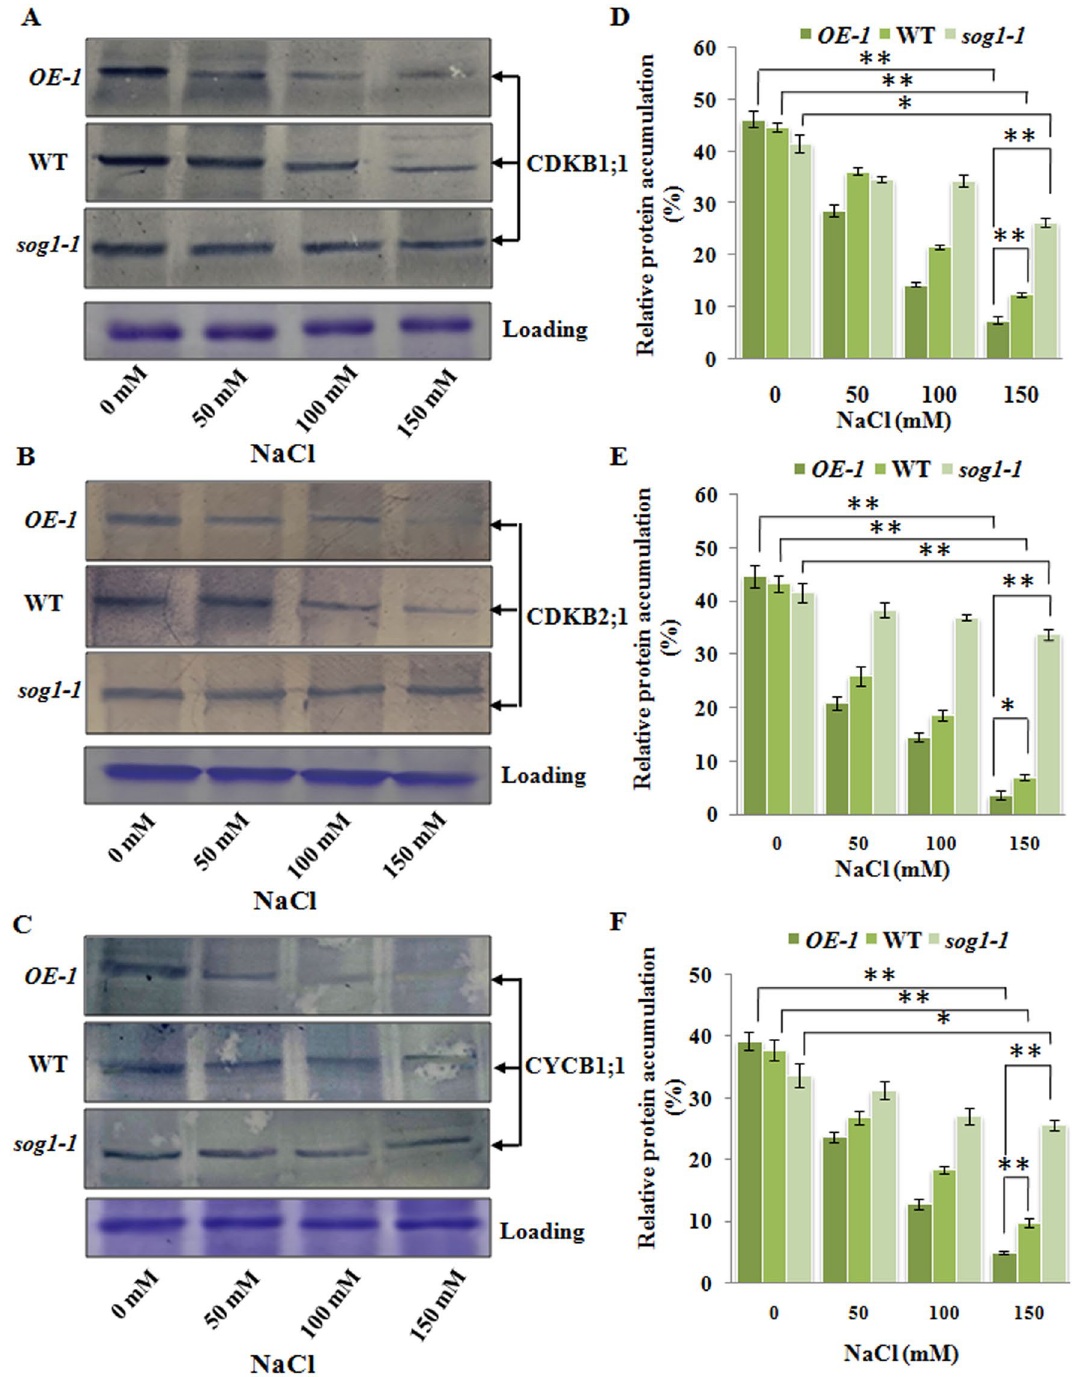
Figure 10. SOG1 is found to control the entry into M-phase and induce cell cycle arrest under salinity stress. ( A – C ) Detection of protein accumulation levels of key regulators of cell cycle progression and endoreduplication including CDKB1;1 ( A ), CDKB2;1 ( B ), CYCB1;1 ( C ), respectively in 7-days old OE-1, wild-type and sog1- 1 seedlings exposed to increasing concentrations of NaCl for 12 h. Loading control of total protein extracts has been presented in the lowermost panel. Immunoblotting was performed by using ~ 50 µg of total protein extracts. The blots were cut prior to incubation with the respective primary antibody\ies. Representative gel blot images from at least three independent experiments are shown. Replicates of the protein gel blots have been presented in Supplementary Fig. S15. ( D – F ) Quantification of band intensity to determine the accumulation levels of CDKB1;1 ( D ), CDKB2;1 ( E ), CYCB1;1 ( F ) proteins as detected by immunoblotting. Densitometry analysis was carried out by ImageJ software (NIH). Error bar indicates standard deviation. Asterisks indicate significant statistical differences (* p < 0.05, ** p < 0.01) from control (without NaCl treatment) using one-way ANOVA factorial